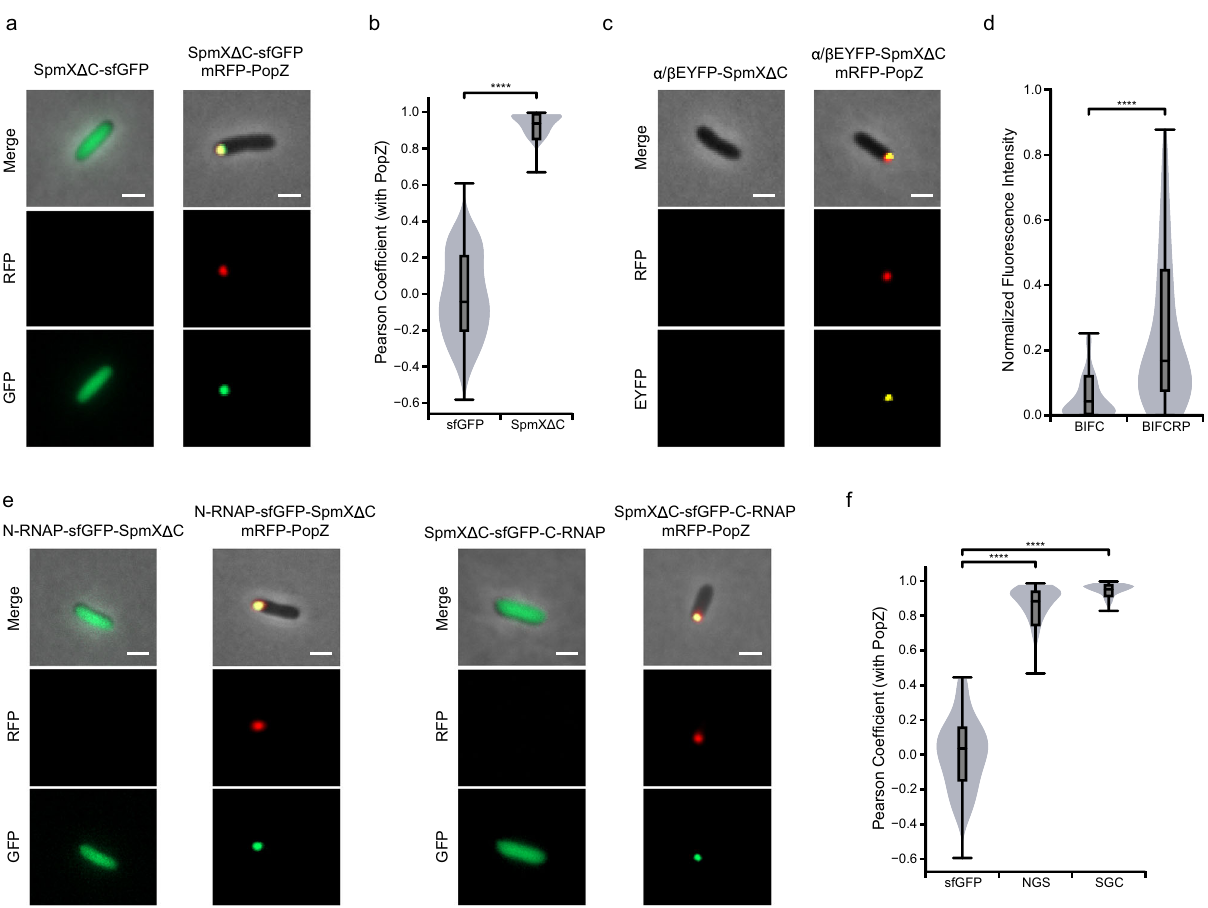
Fig. 2 PopZ functions as a polarized scaffold in E. coli . a Recruitment of SpmX Δ C to PopZ. SpmX Δ C-sfGFP and mRFP-PopZ were expressed from the Anderson promoters J23113 and J23116, respectively. SpmX Δ C-sfGFP was diffused when expressed alone (left) and co-localized with PopZ when co- expressed with mRFP-PopZ (right). Scale bars: 1 μ m. b Quanti fi cation of co-localization with PopZ in a ( “ Methods ” ). Co-expression of sfGFP and mRFP- PopZ was used as the baseline for comparison (Supplementary Fig. 5); n = 82 and 77 cells for sfGFP and SpmX Δ C, respectively. Center line, median; box limits, upper and lower quartiles; whiskers, 1.5× interquartile range. Statistical difference was determined by two-tailed Student ’ s t -test; **** denotes P < 0.0001. c Fluorescence protein complementation via PopZ. The α and β halves of EYFP fused with SpmX Δ C were expressed from the Anderson promoter J23117, and mRFP-PopZ was expressed from J23116. Fluorescence was signi fi cantly higher when the α and β halves of EYFP fused with SpmX Δ C were co- expressed with mRFP-PopZ. Scale bars: 1 μ m. d Quanti fi cation of fl uorescence in c . BIFCRP and BIFC denote α and β halves of EYFP fused with SpmX Δ C were with or without mRFP-PopZ co-expression, respectively; n = 125 and 77 cells for BIFCRP and BIFC, respectively. Center line, median; box limits, upper and lower quartiles; whiskers, 1.5× interquartile range (IQR). Fluorescence intensity was normalized by the upper IQR in BIFCRP. Statistical difference was determined by two-tailed Student ’ s t -test; **** denotes P < 0.0001. e PopZ recruitment of the two halves of PACE-evolved T7 RNA polymerase fused to SpmX Δ C. Both SpmX Δ C fused PACE-evolved T7 RNA polymerase halves were induced from the P tac promoter with 1 mM IPTG for 1 h. mRFP-PopZ was expressed from the Anderson promoter J23116. Scale bars: 1 μ m. f Quanti fi cation of co-localization with PopZ in e ( “ Methods ” ). NGS and SGC denote RNAP-N-sfGFP-SpmX Δ C and SpmX Δ C-sfGFP-RNAP-C, respectively. Co-expression of sfGFP and mRFP-PopZ was used as a baseline for comparison (Supplementary Fig. 5); n = 83, 118, and 140 cells for sfGFP, NGS, and SGC, respectively. Center line, median; box limits, upper and lower quartiles; whiskers, 1.5× interquartile range. Statistical difference was determined by two-tailed Student ’ s t -test; **** denotes P < 0.0001. Source data are provided as a Source Data fi